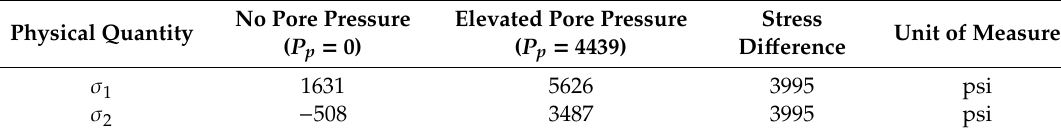
Table 2. Principal stress magnitudes at x = 0 and y = 0.